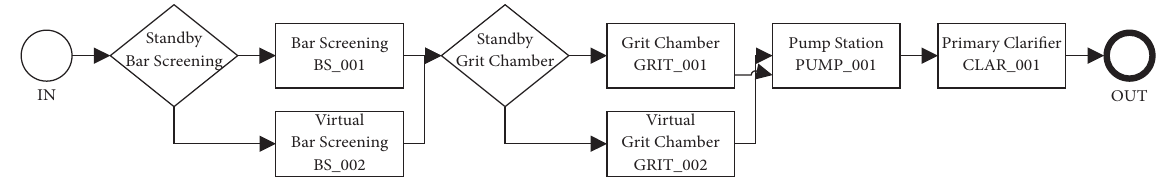
Figure 8: Graphical representation of modelling-VSB